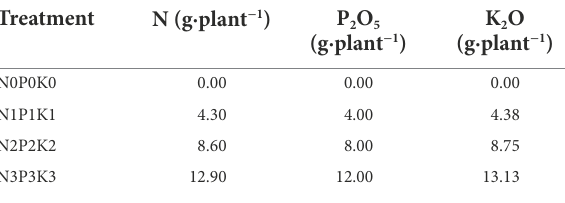
TABLE 1 The amount of fertilizer used in the experiment